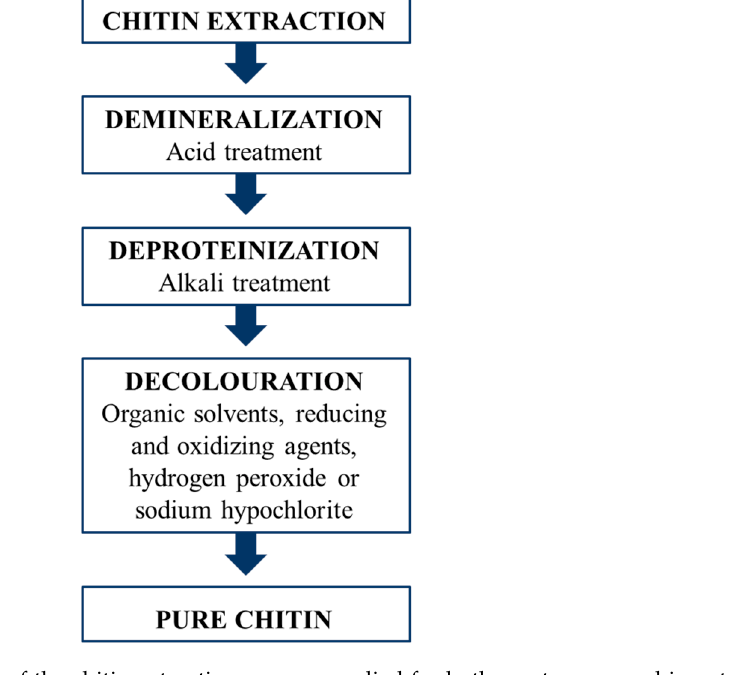
Figure 4. Schematic representation of the chitin extraction process applied for both crustaceans and insects, involving demineralization, removal of proteins and bleaching.